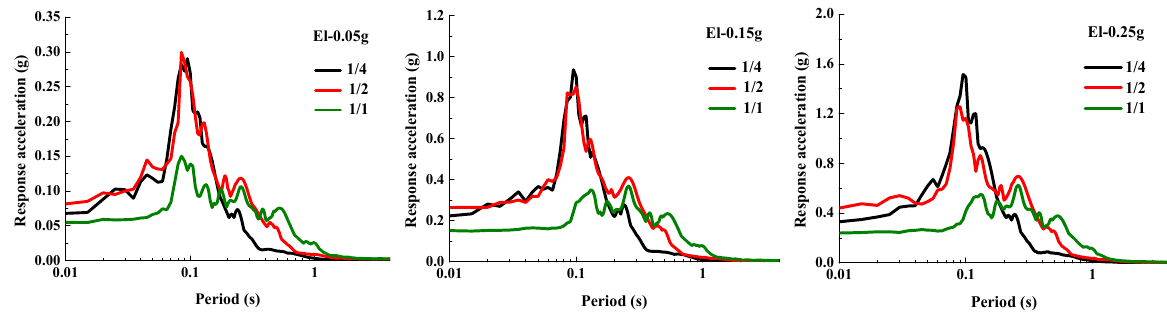
Figure 12. Acceleration response spectra of the measuring point AX6 under scaled El Centro rec- ords.